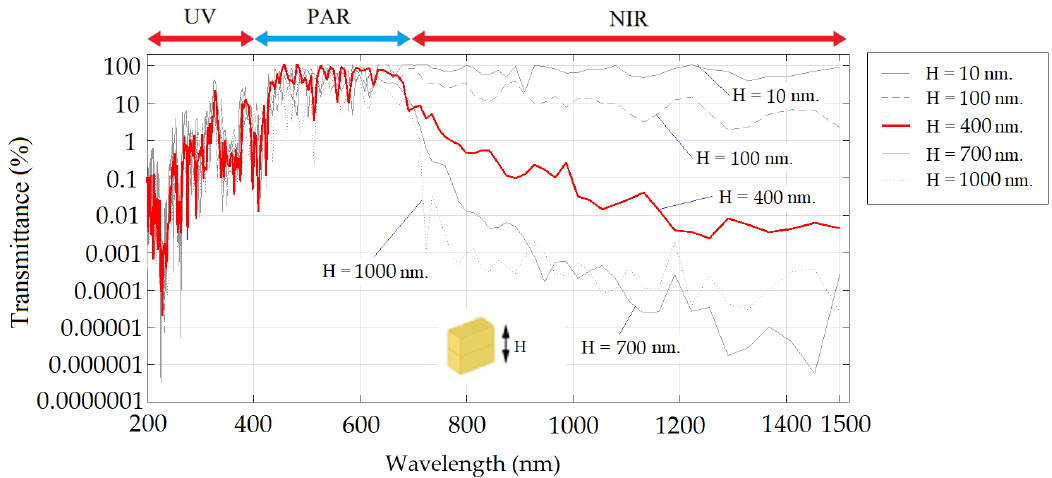
Figure 7. Transmittance when H is varied from 10 nm to 1000 nm.